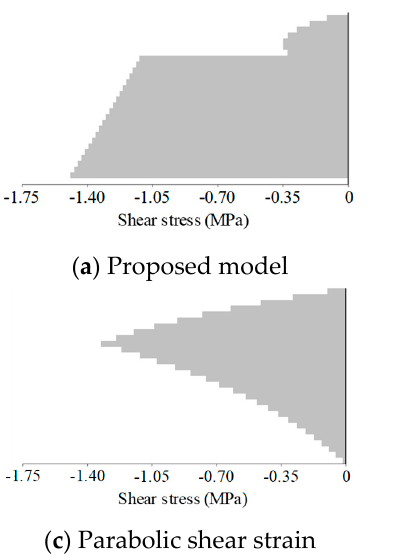
Figure 14. Shear stress distribution over cross section (at critical section, 54.7 kN V